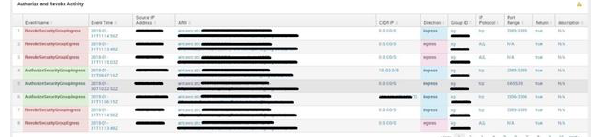
Figure 3. Splunk Sample Authorize VS Revoke activity for Security Groups